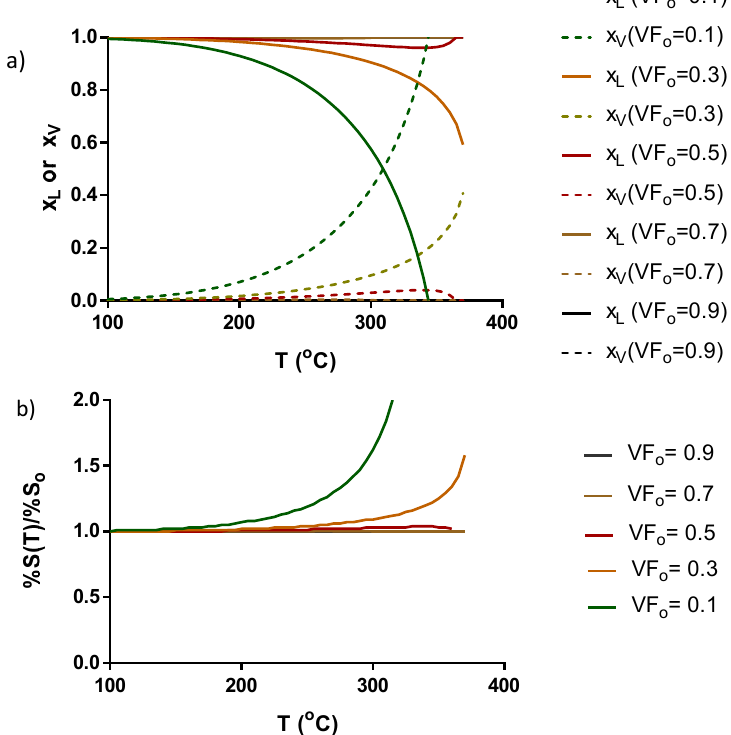
Figure 5. Changes in process parameters at various initial VF o as the operating temperature increases for ( a ) mass fractions of water in liquid x L and vapor x V , ( b ) the ratio of actual to nominal solid content in the reactor system, %S(T) at T to %S o at the initial temperature.